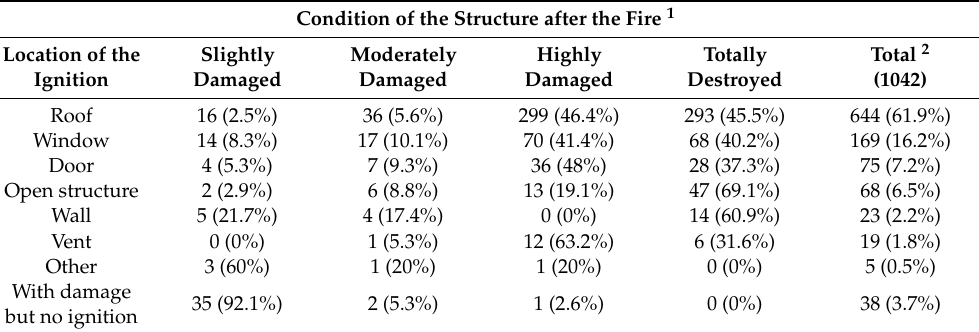
Table 11. Degree of damage according to the location of the